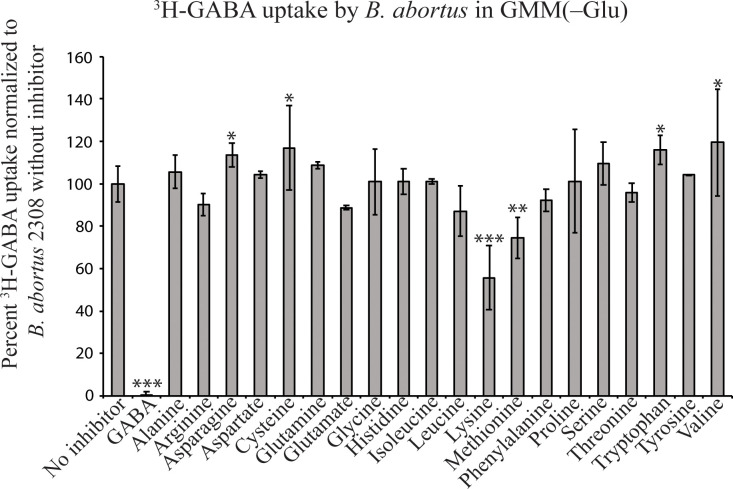
3H-GABA import by B. abortus 2308 is not greatly inhibited by the presence of other amino acids in vitro.3H-GABA uptake by B. abortus 2308 was assessed uninhibited and in the presence of 1,000-fold excess GABA or 20 proteinogenic amino acids. Data is normalized to the absence of inhibitor at 100%. The asterisk denotes a statistically significant difference (* P<0.05, ** P<0.005, *** P<0.0005; Student’s t test) in uptake of 3H-GABA between B. abortus 2308 uninhibited (no inhibitor) and in the presence of excess nonradiolabled GABA, asparagine, cysteine, lysine, methionine, and tryptophan.